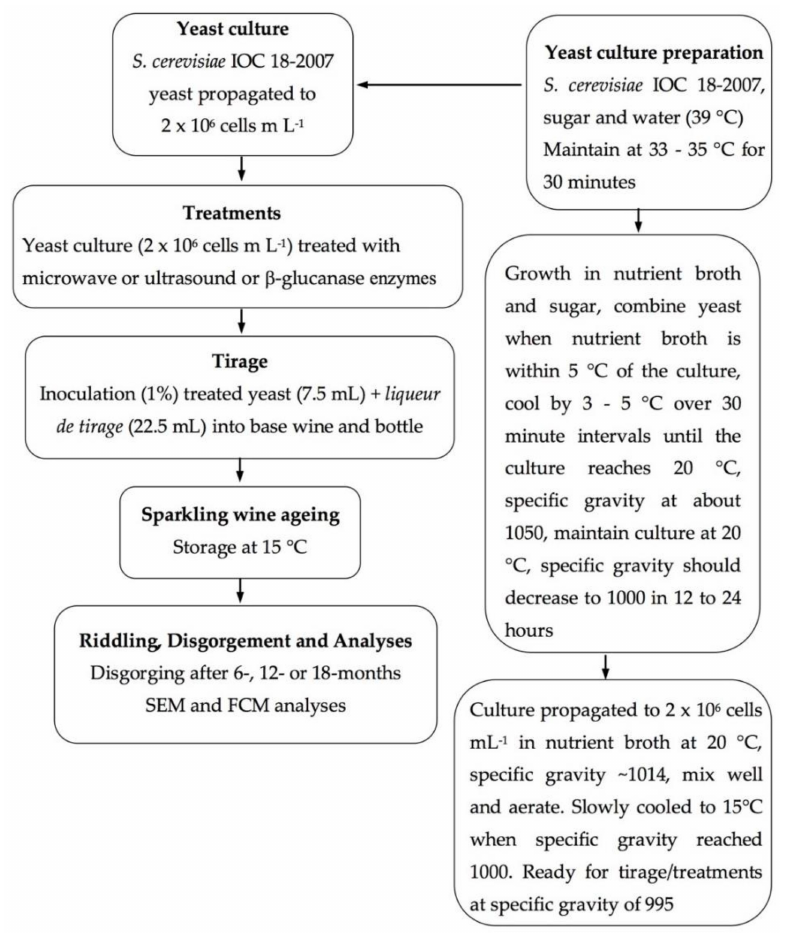
Figure 8. Flow diagram of sparkling wine production using yeast treatments at the tirage